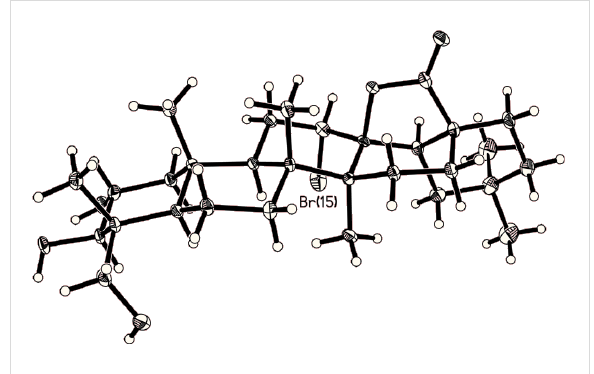
Figure 3: X-ray structure of arjuna-bromolactone 3 . The length of the molecule (3O•••30C) is 1.26